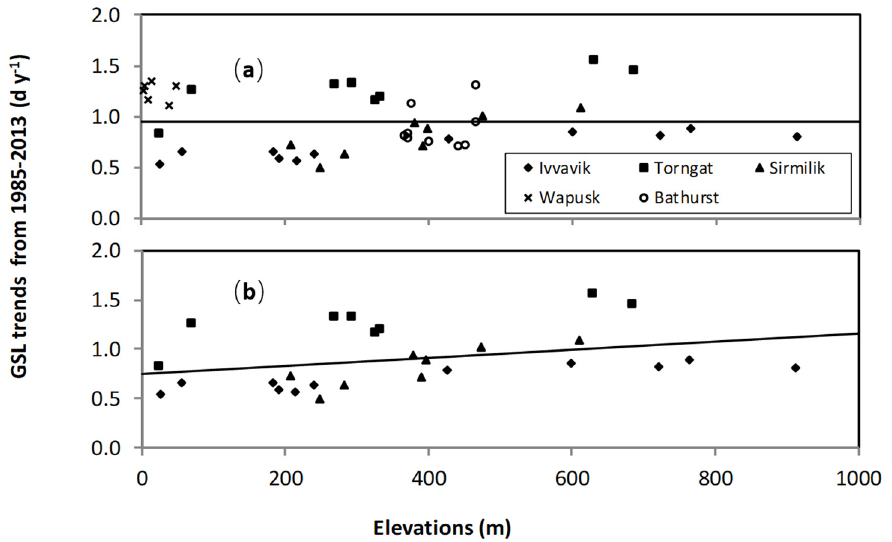
Figure 9. Relationships between GSL trends and elevation when data are pooled ( a ) upper panel: from all the five study areas in the upper panel ( R 2 = 0.0001, p -value = 0.94, n = 42), and ( b ) lower panel: from all three mountainous study areas in the lower panel ( R 2 = 0.103, p -value = 0.102, n = 27).